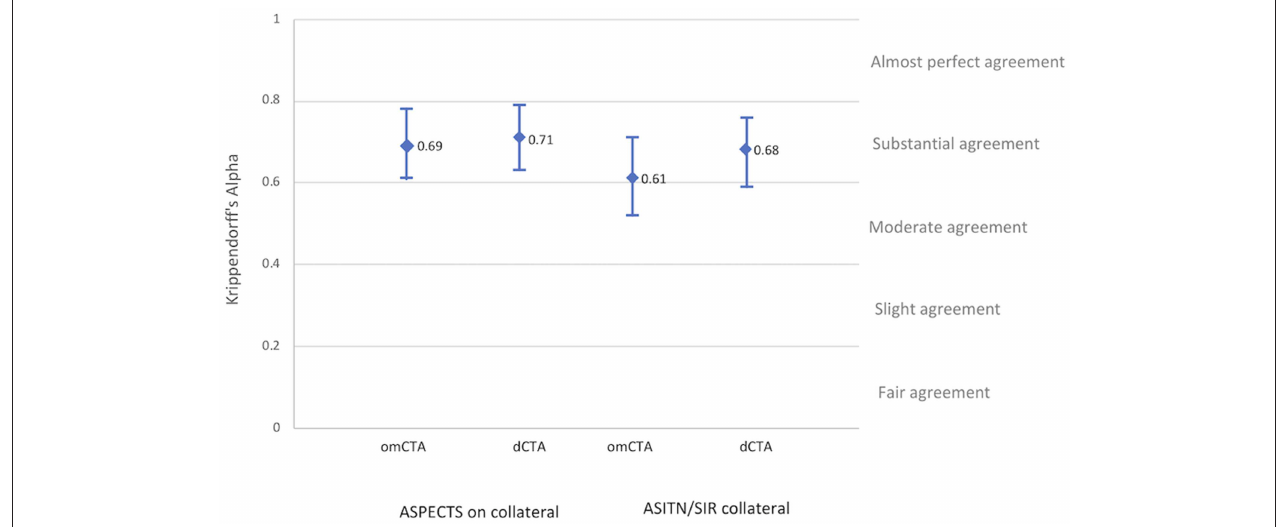
Frontiers in Neurology |